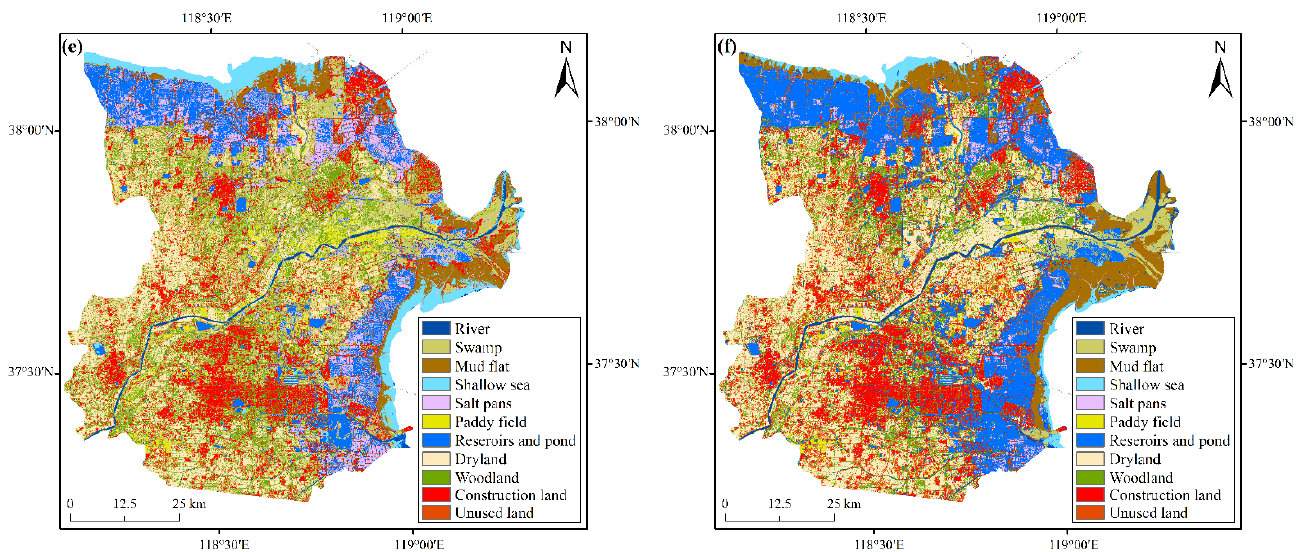
Figure 5. The spatial distributions of wetlands in 2021: ( a ) spectral feature; ( b ) spectral feature + vegetation index + water index; ( c ) spectral feature + red-edge index; ( d ) spectral feature + texture feature; ( e ) all features; ( f ) the optimal feature variable sets.